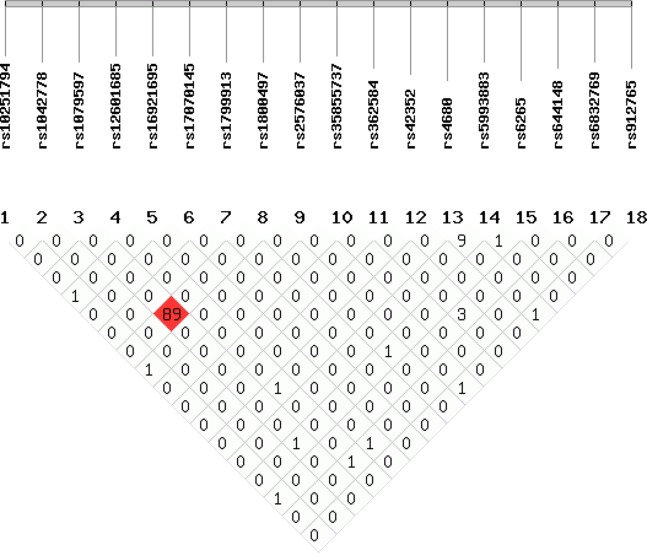
Linkage disequilibrium map.Numbers in squares indicate the degree of LD (r2 value*100) between any two SNPs.